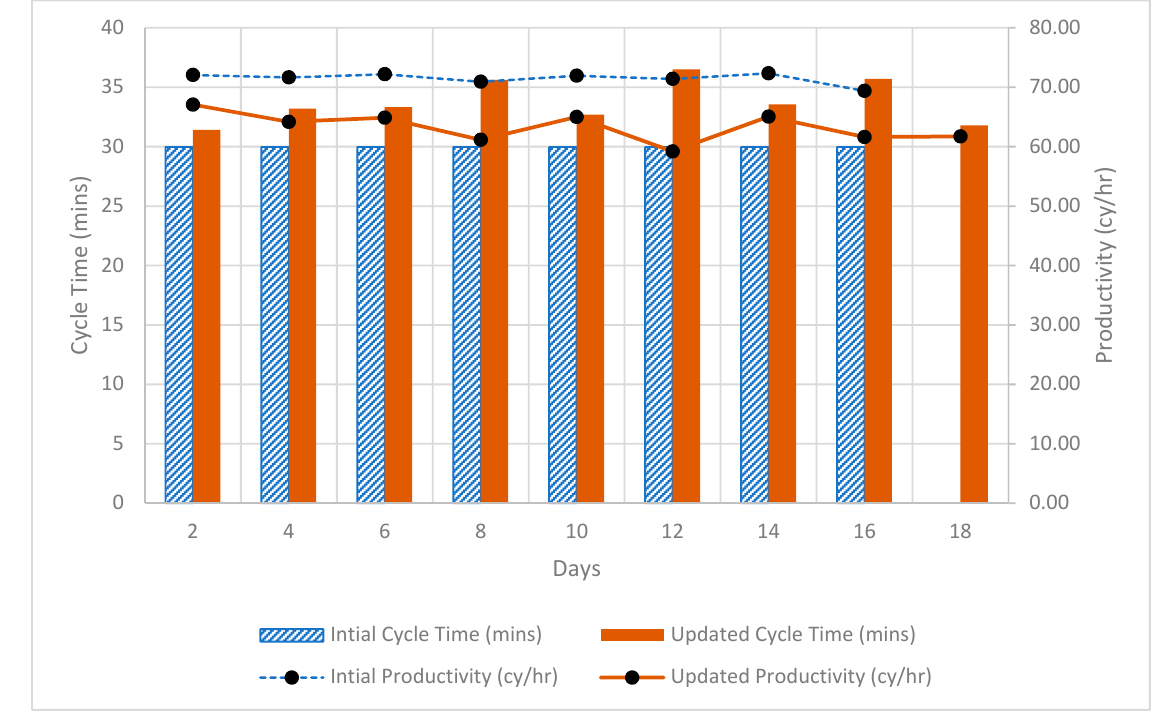
Figure 16. Cycle times and productivities using initial and updated cycle times.